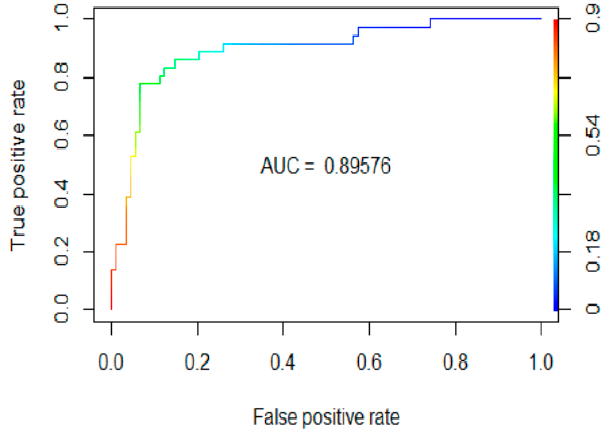
Figure 2. ROC curve of OOB data.